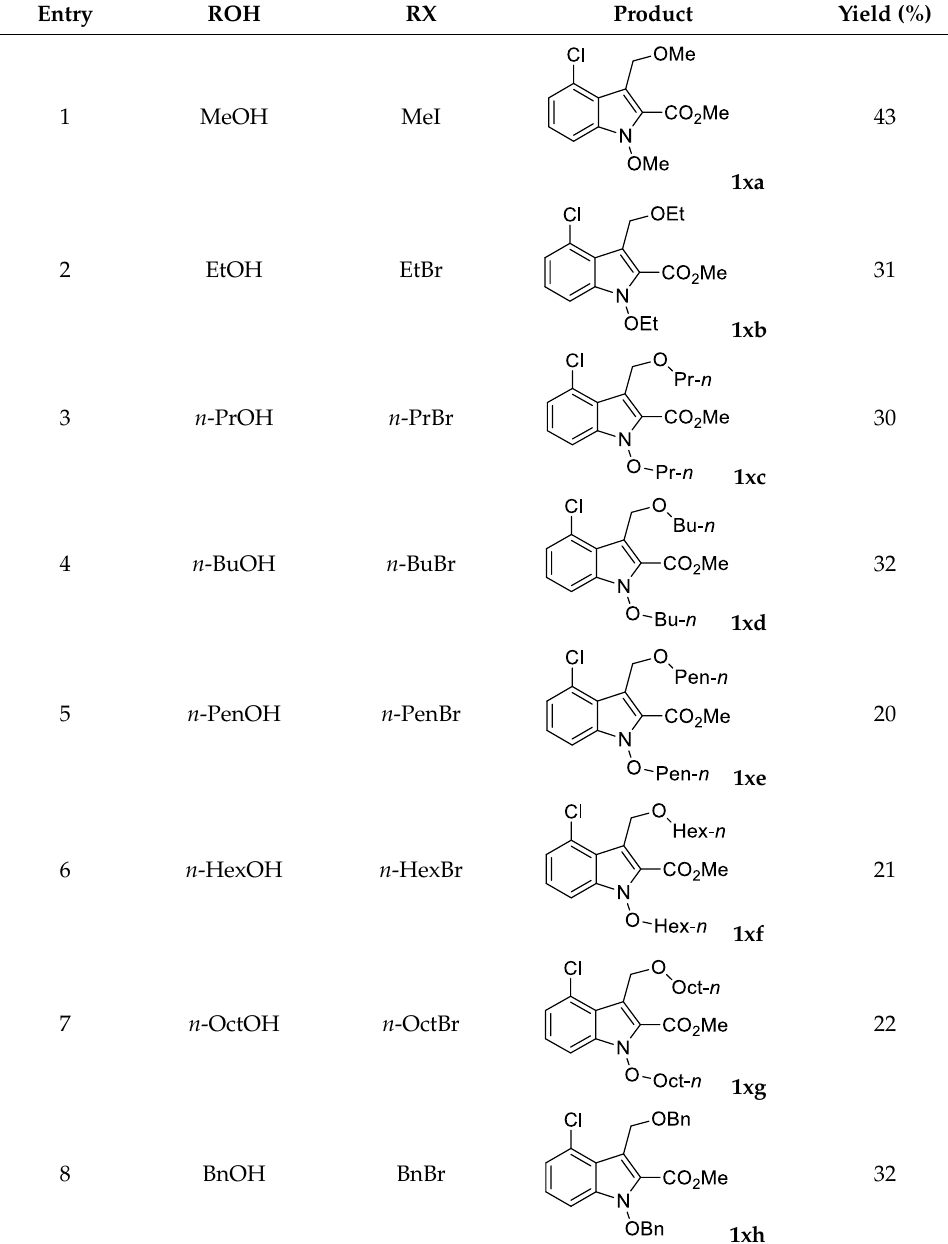
Table 3. Synthesis of derivatives of 1-alkoxyindole 1 a .